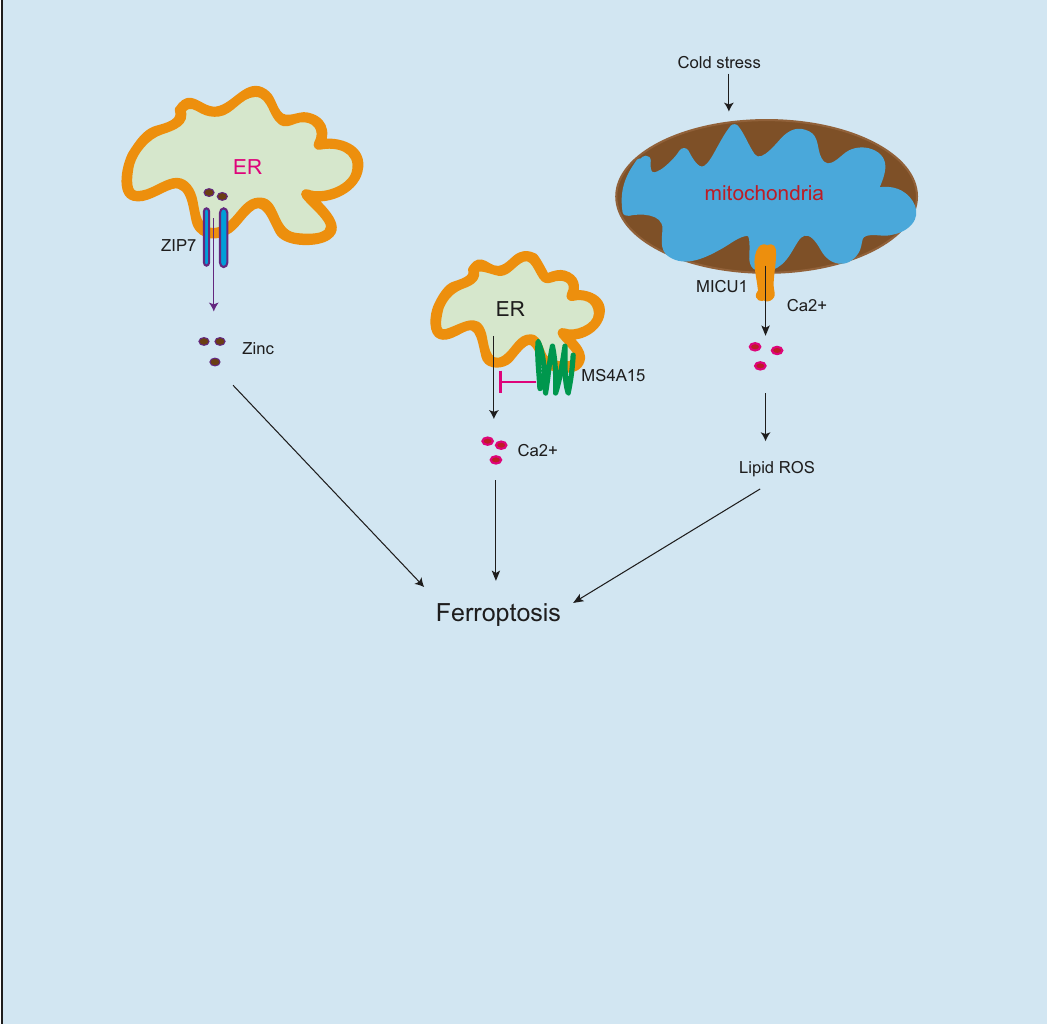
Fig. 4 Regulation of ferroptosis by metallic irons. In addition to iron, zinc and calcium could induce ferroptosis. ZIP7 mediates zinc release from ER to cytosol resulting in ferroptosis. In addition, cold stress increases lipid peroxidation accumulation and induces ferroptosis, which is associated with MICU1-dependent mitochondrial Ca2 + uptake. However, calcium (Ca2 + )-mediated ferroptosis could be blocked by MS4A15, which in turn inhibits the additional role of T cell killing to cancer cells by induction of ferroptosis. Since cyst(e)inase treatment can induce intracellular cystine degradation consequent promotion of cancer cell ferrop- tosis [88], the combined cyst(e)inase with PD-L1 antibody effectively enhances tumor immunotherapy [86], suggesting that combined ferroptosis inducers with immune checkpoint inhibitors could effectively enhance cancer immunotherapy. In contrast to T cell killing to cancer cells by ferroptosis induction, in tumor microenvironment, cholesterol-mediated CD8( + ) T cell ferroptosis leads to cancer cell immune escape [89]. In this process, cholesterol induces CD36 expression on tumor-in fi ltrating CD8( + ) T cells, consequently, CD36 triggers uptake of fatty acids in CD8( + ) T cells resulting in ferroptosis. In contrast, block of CD36 enhancesant-PD- 1 antitumor immunotherapy [89], suggesting that ferroptosis inducers could impair T cell survival. In contrast to CD8( + ) T cell killing to cancer cells, T regulatory (Treg) cells exhibit immune tolerance and inhibit antitumor immunotherapy, and high levels of GPX4 in Treg cells prevent lipid peroxidation and ferroptosis. In contrast, blockade of GPX4 enhances antitumor immunotherapy [90]. As a deubiquitinating enzyme, OTUD1 facilitates ferroptosis by